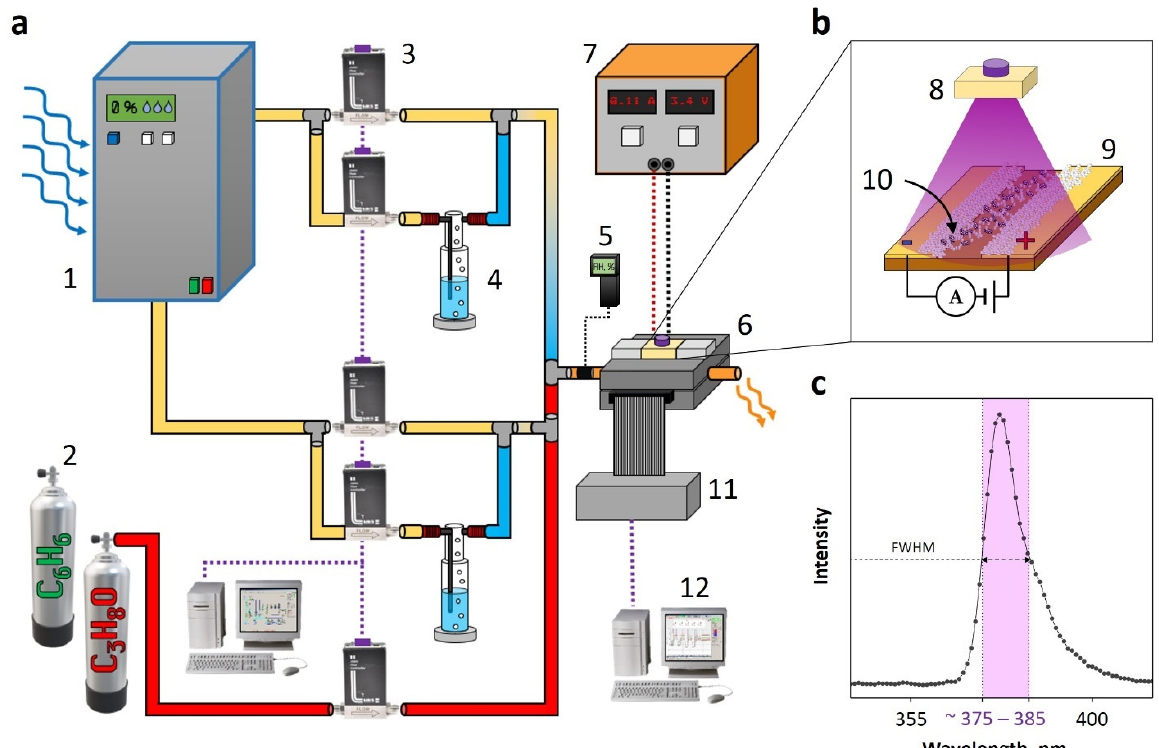
Figure 2. The experimental setup to measure the chemiresistive effect in electrochemically deposited ZnO nanostructured layer under variable gas exposure and UV activation: ( a ) drawing of the setup, 1—dry air generator, 2—bottles with calibrated analyte gases, 3—mass flow meters; 4—deionized water bubblers; 5—hygrometer/thermometer; 6—a sealed chamber containing the multielectrode chip, 7—UV power supply unit, ( b ) the scheme of UV irradiation the chip surface, 8—UV LED, 9—measuring Pt electrodes confining the deposited ZnO layer (10), 11—KAMINA unit, 12—PC; ( c ) the measured spectrum of LED emission.